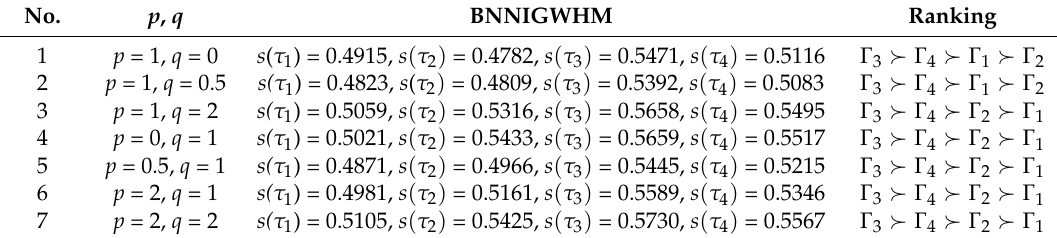
Table 2. Ranking results with different values of p and q based on bipolar neutrosophic number improved generalized weighted Heronian mean (BNNIGWHM) operator.